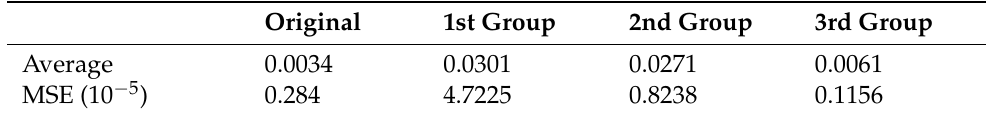
Table 3. Comparison of simulation training